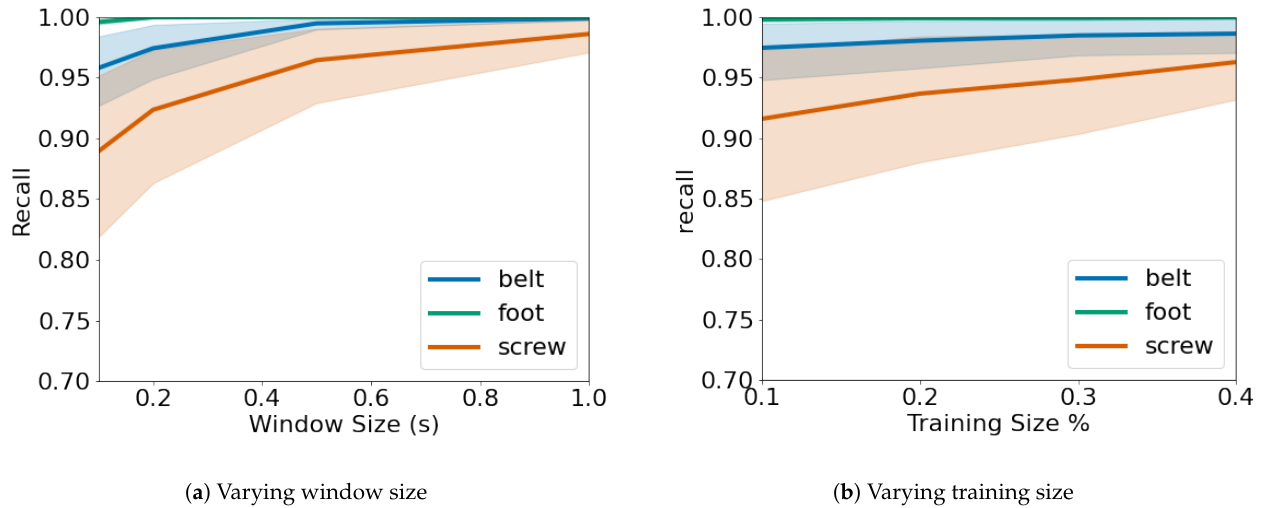
Figure 6. Recall of the classifier versus the window size ( a ) and versus the training size ( b